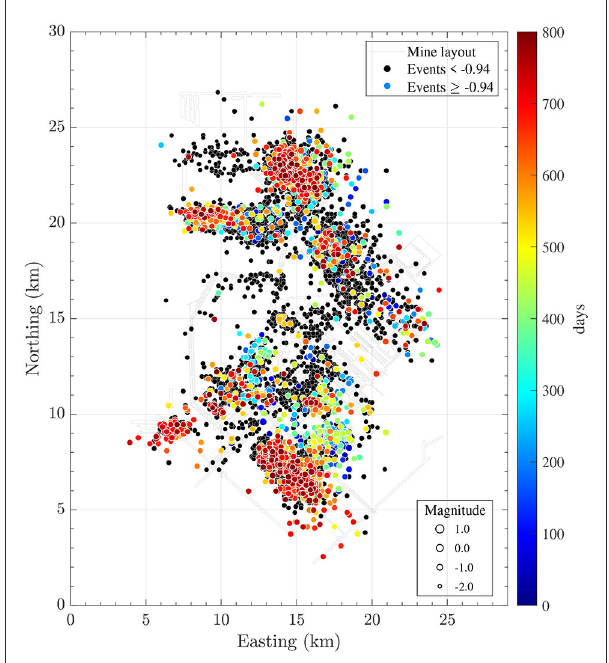
FIGURE1 The plot of the epicenters of microseismicity in a potash mine in Saskatchewan, Canada. The events were recorded from May 1, 2019, to July 9, 2021. The colored solid circles represent events with magnitudes above m 0.94. Different colors indicate the time of ≥ − the occurrence of events and are given by the color bar with the corresponding times in days starting from May 1, 2019. All other m < events between magnitudes 2.97 0.94 are shown as black − ≤ − solid circles. The light gray lines illustrate the layout of the mine which includes the mine shafts and